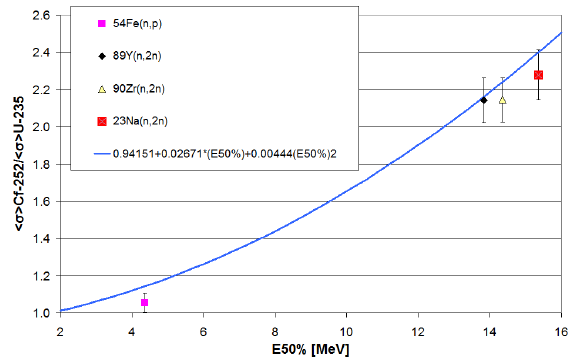
Figure 3. Ratios of the 252 Cf and 235 U SACS in dependence on E50% fitted with quadratic